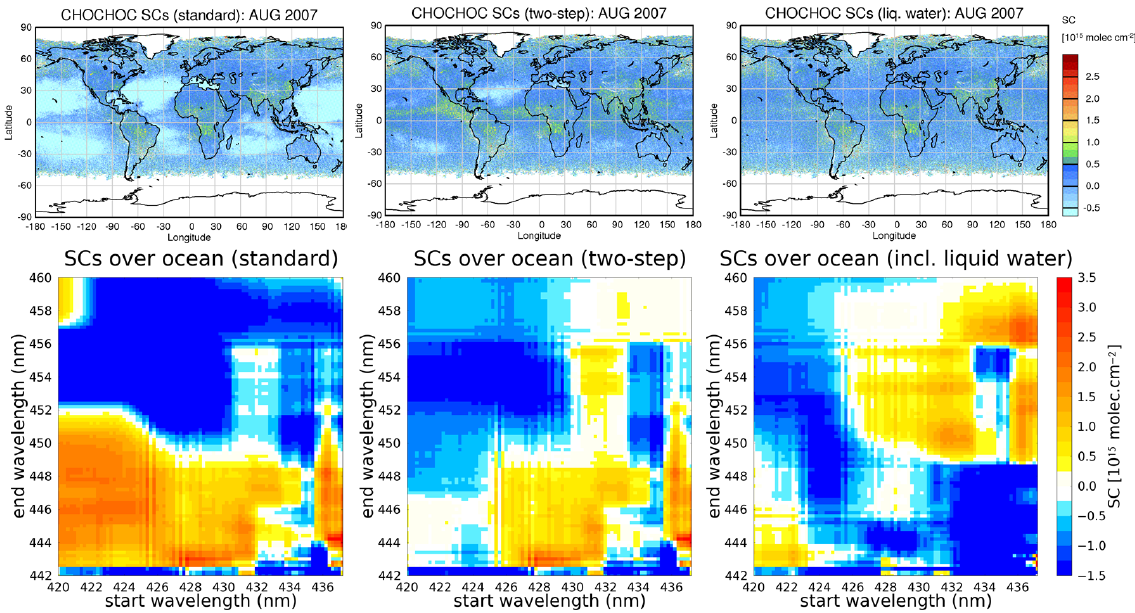
Figure 4. Maps of monthly averaged glyoxal slant columns retrieved from OMI measurements for August 2007 (top). Cloud screening has been applied in all maps (see Sect. 3). CHOCHO SCs obtained using the standard CHOCHO retrieval without liquid water absorption cross- section (left), by using the two-step fit (centre), and including the liquid water absorption cross-section in the standard CHOCHO retrieval (right). CHOCHO SC means retrieved over ocean (latitude: 25.0 ◦ ± 1 . 0 ◦ ; longitude: 144.0 ◦ ± 1 . 0 ◦ ) from OMI measurements for the three different retrievals on 1 August 2007